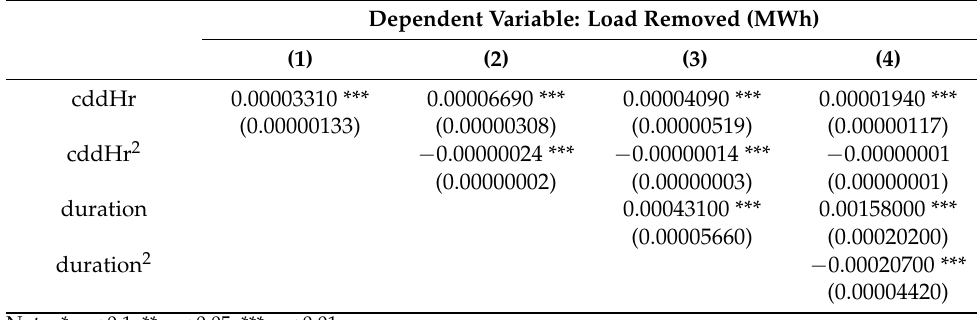
Table 3. Load-removed–panel fixed effects with clustered standard errors (household).